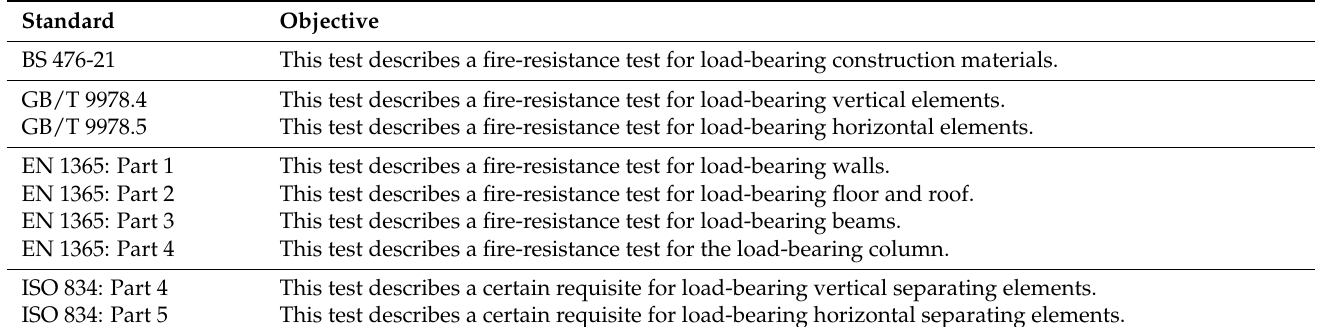
Table 3. Fire-resistance standards for load-bearing construction elements.